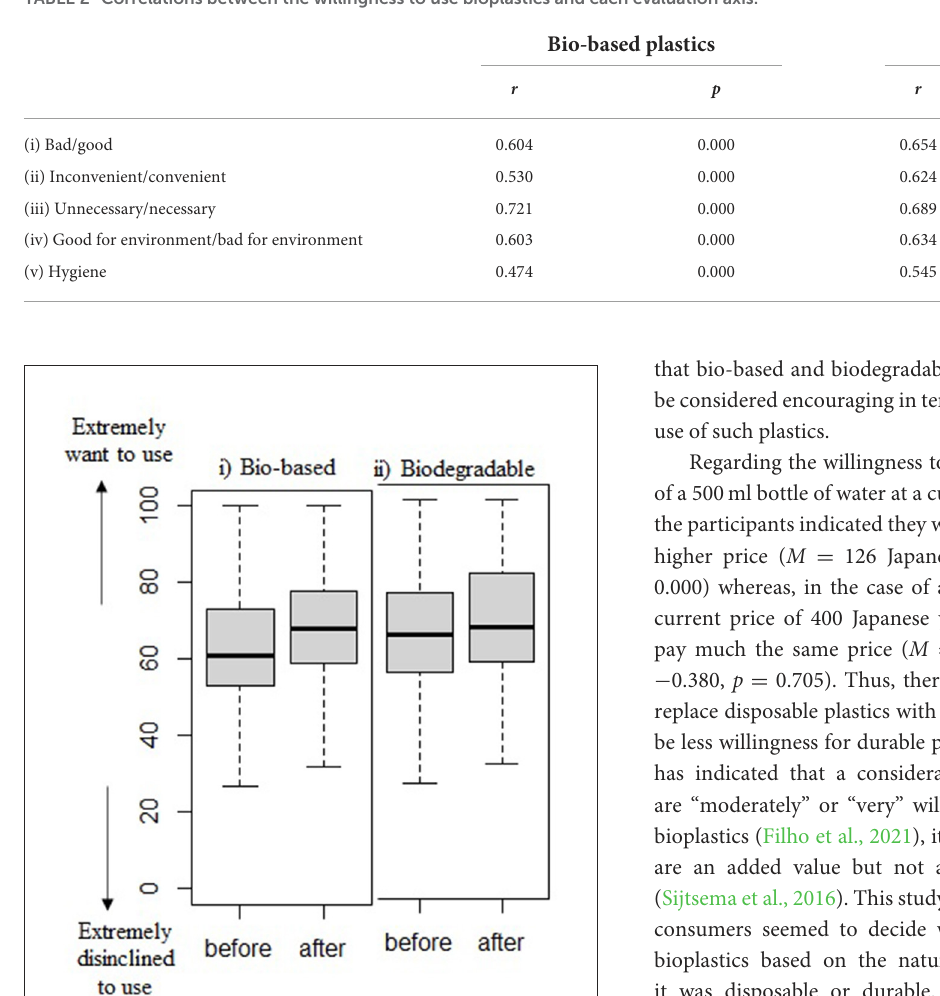
TABLE 2 Correlations between the willingness to use bioplastics and each evaluation axis.